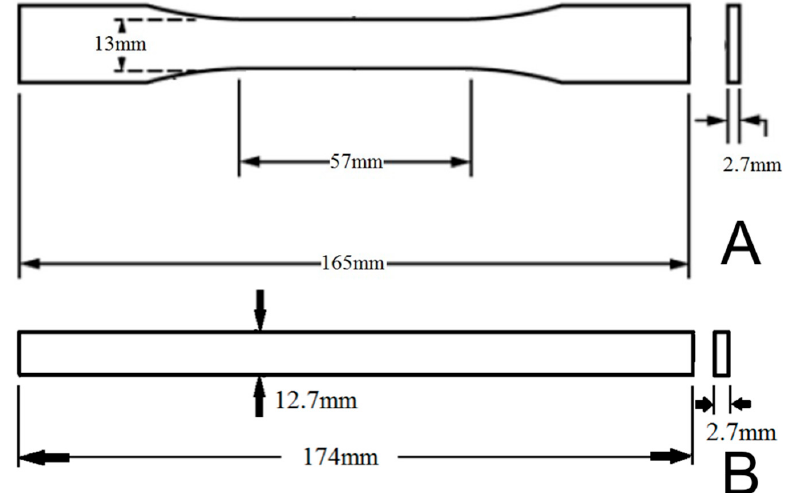
Figure 1. ( A ) Schematic of the tensile specimen shape and dimensions based on ASTM D638-14 standard [63]; ( B ) Schematic of the flexural specimen shape and dimensions based on ASTM D790-15 standard [64].